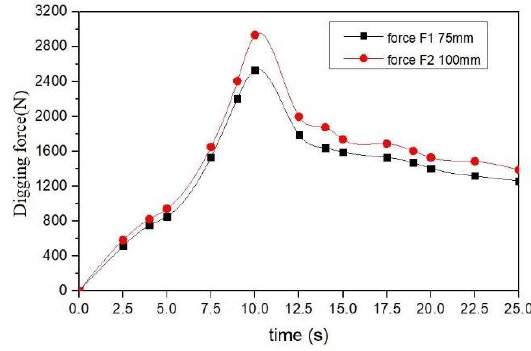
Figure 16. Flat digging force diagram.